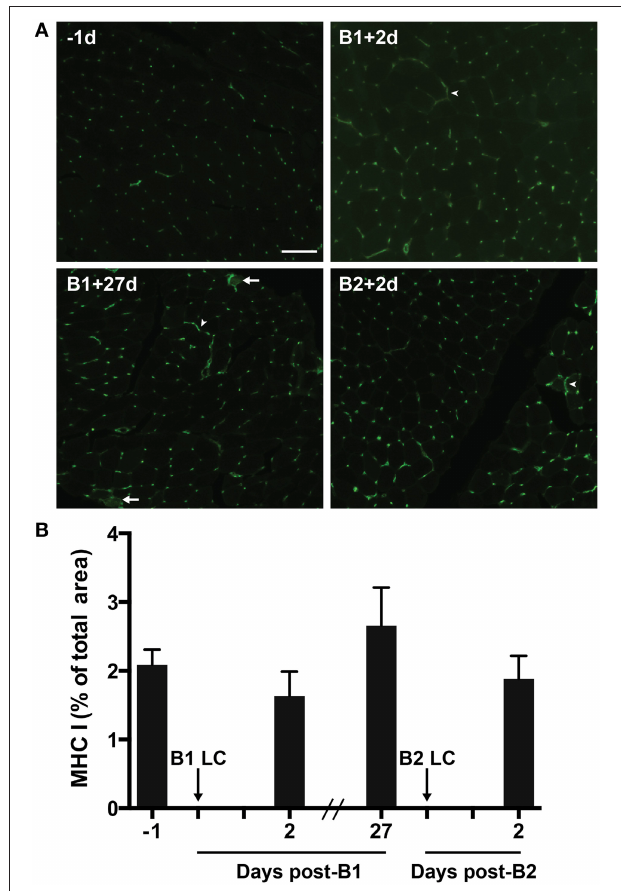
FIGURE 5 | Major histocompatibility complex class 1 (MHC-1) in skeletal muscle tissue. (A) A representative florescent image of 8 µ m thick muscle cross-sections stained for MHC-I. All four images were taken from muscle samples from the same subject 1 day before bout 1 (B1) of damaging lengthening contractions (LC) ( − 1d), 2 days after B1 (B1 + 2d), 27 days after bout 1 (B1 + 27d) and 2 days after bout 2 (B2) (B2 + 2d). Arrowheads show MHC-I positive sarcolemmal immunoreactivity. Arrows show MHC-I positive sarcoplasmic staining. (B) Percent of total muscle section positive for MHC-I before and after B1 and B2 of LC. No significant differences observed (One-way repeated measures ANOVA with Tukey’s HSD, p < 0.05 ). Scale bar = 100 µ